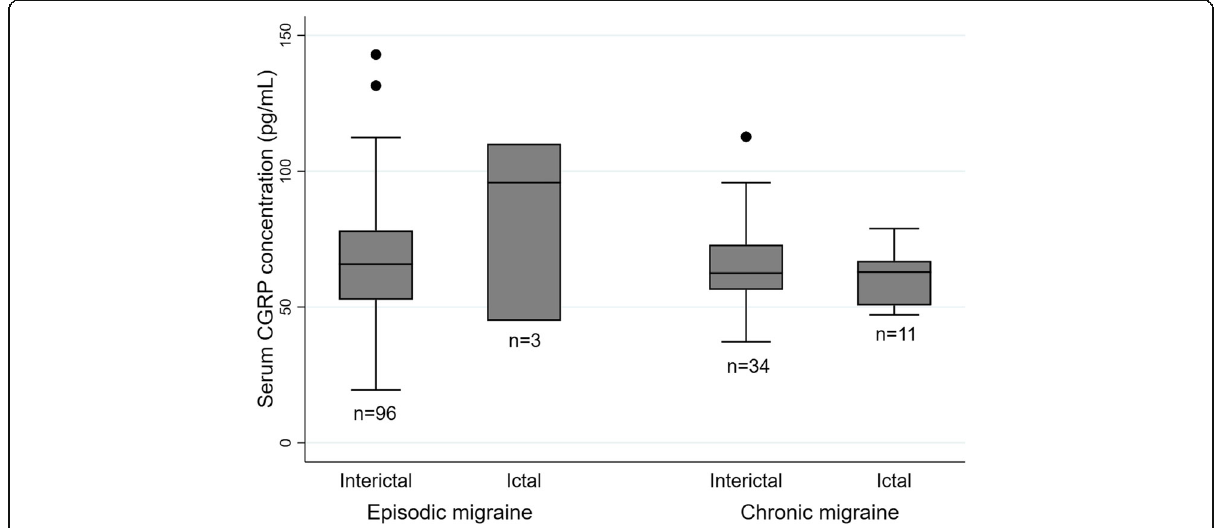
Fig. 3 Comparison of serum CGRP concentration between interictal vs. ictal measurement respectively in patients with EM and those with CM